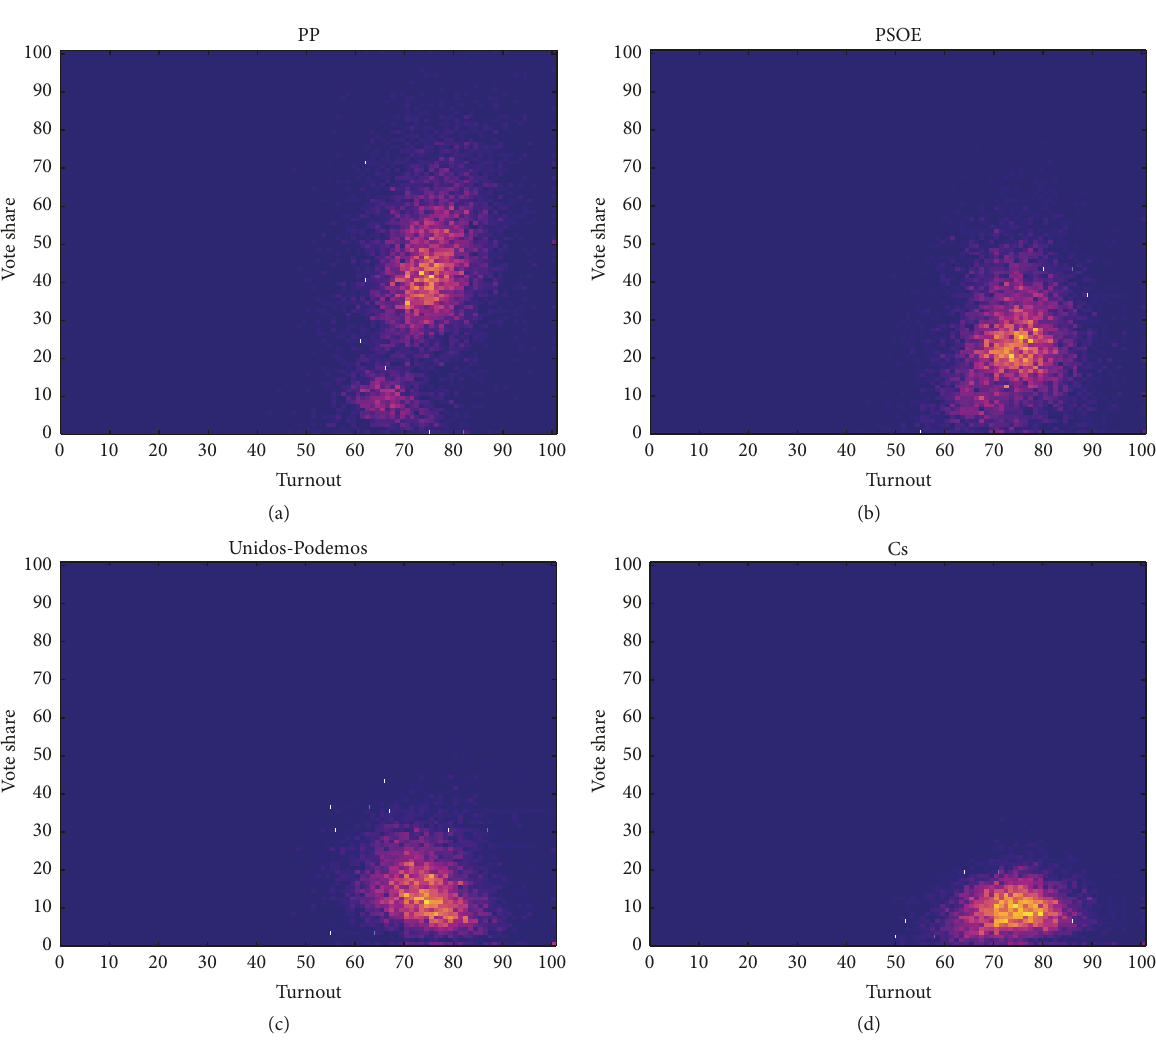
Figure 16: Heat maps plotting the percentage (in color scale) of municipalities where a given political party has received a certain percentage of votes, as a function of the relative participation. These are results from the 2016 elections; the 2015 case is reported in Figure 17. According to Klimek et al. [5], a smear out of the cluster towards the top-right corner of the heat map is a sign of incremental fraud, whereas extreme fraud would occur for bimodal distributions where a cluster emerges at the top-right